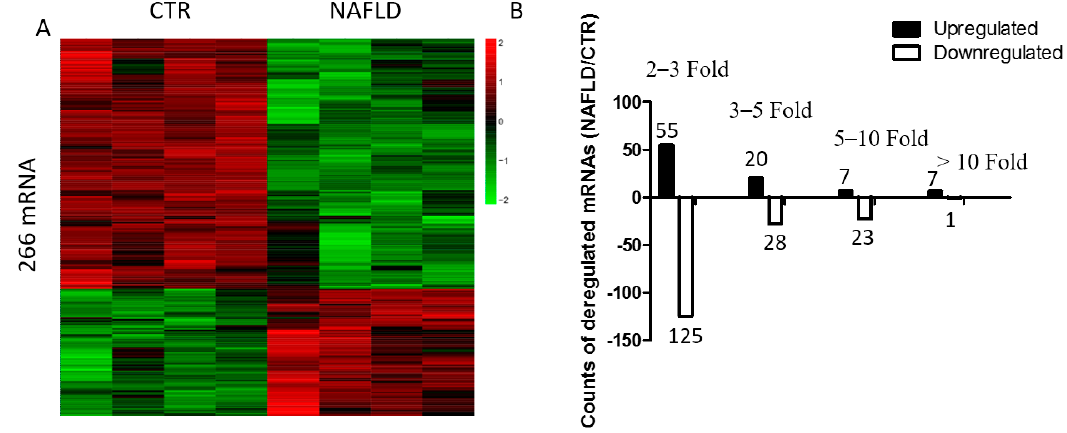
Figure 2. Microarray result of mRNA profile in NAFLD. ( A ) Heat map of differentially expressed mRNAs in control and NAFLD mice. Each row shows relative levels of each mRNA expression and each column represents expression levels for a single sample. Relative high (red) or low (green) expression is indicated; ( B ) Expression profiling of mRNAs in NAFLD and control mice. Determination of upregulated and downregulated mRNAs was based on more than two-fold changes of the normalized probe signal intensity in NAFLD compared with control. Black bars represent the number of upregulated mRNAs, whereas white bars represent the number of downregulated mRNAs. In GO analysis, “oxidation reduction”, “microsome”, and “glutathione transferase activity”